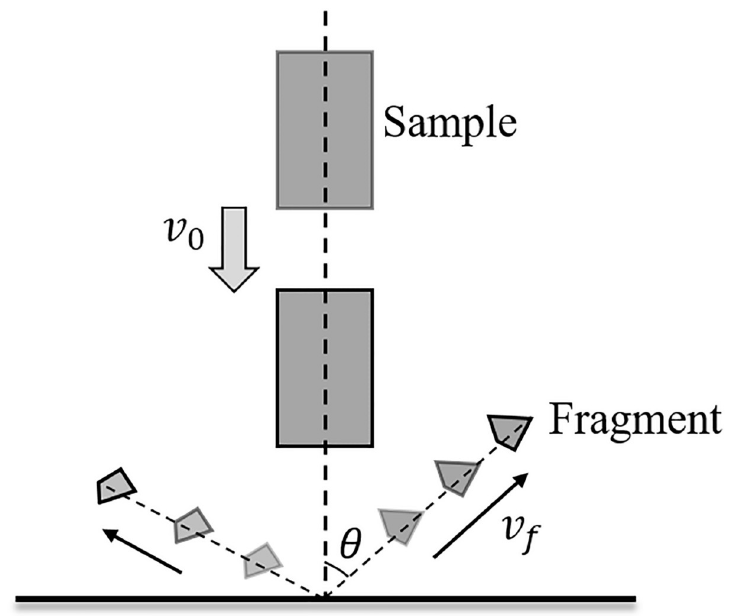
Fig 19. Schematic diagram of fragment flying velocity and